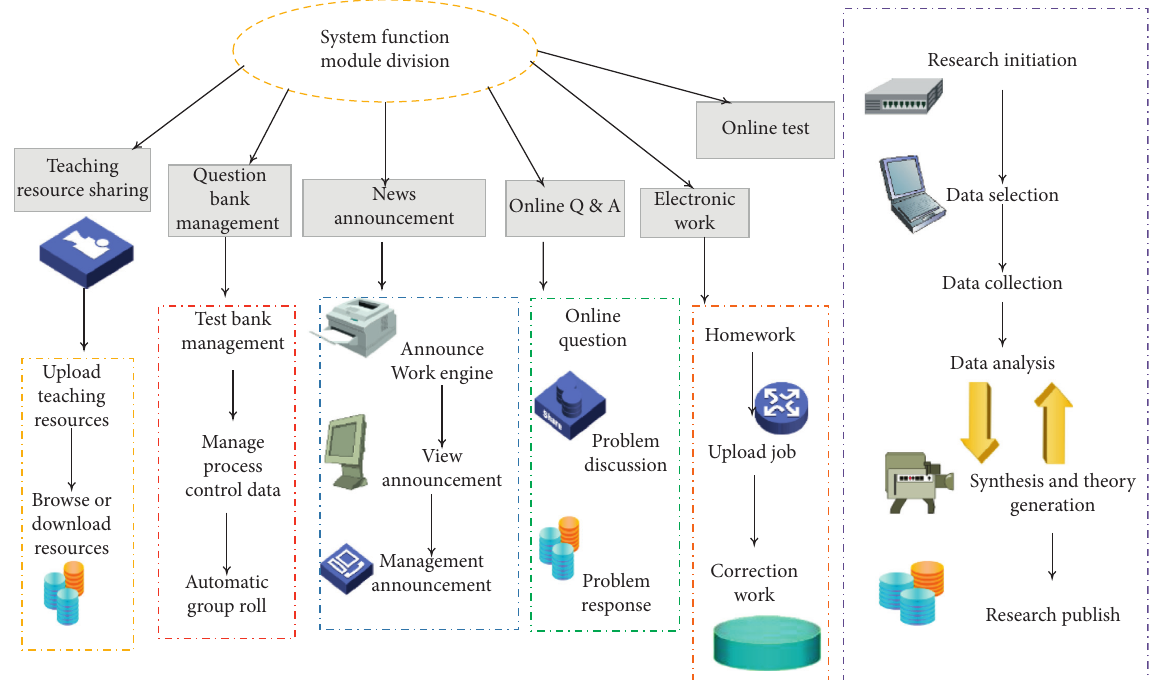
Figure 1: System functional structure